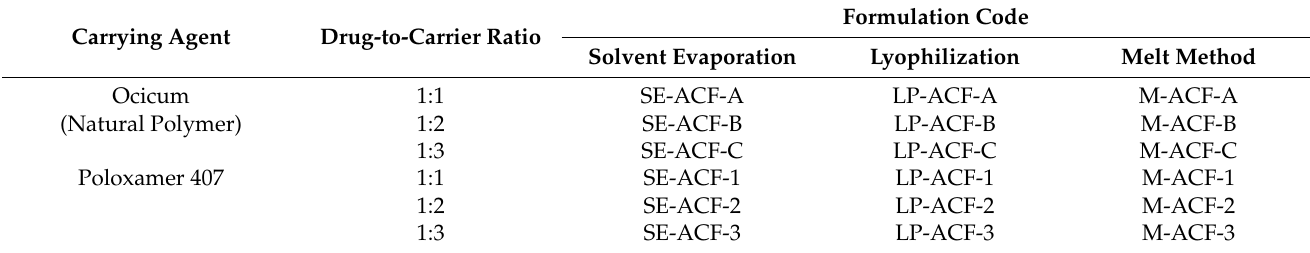
Table 3. Composition of solid dispersion of ACF with NP and Poloxamer